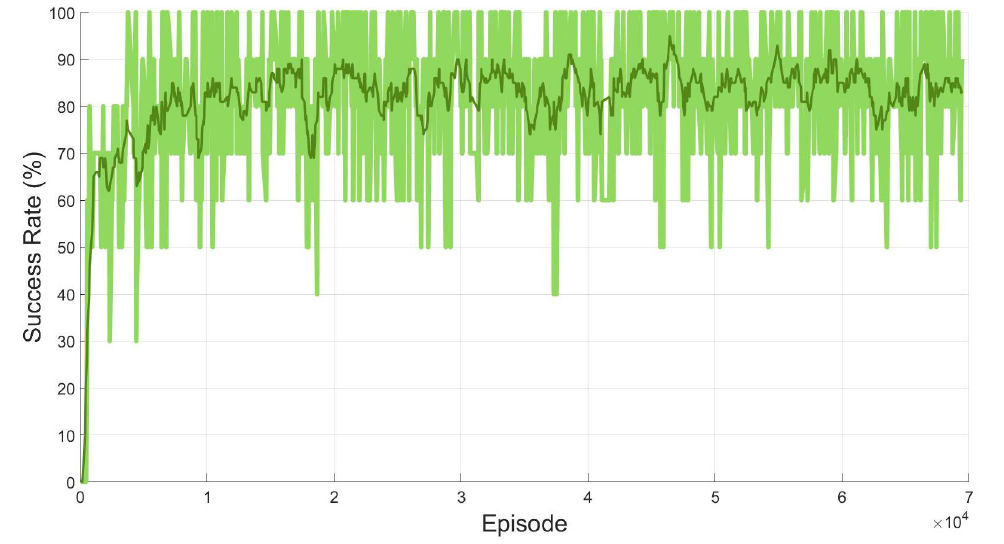
Figure 7. Success ratio of the proposed method for two open manipulators with moving